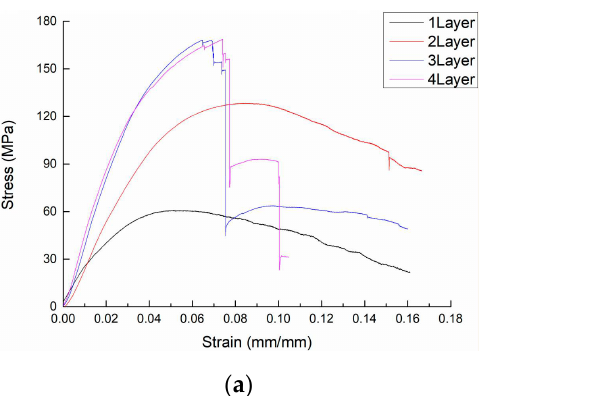
Figure 1. Schematic diagram of 3DDAI fabric.